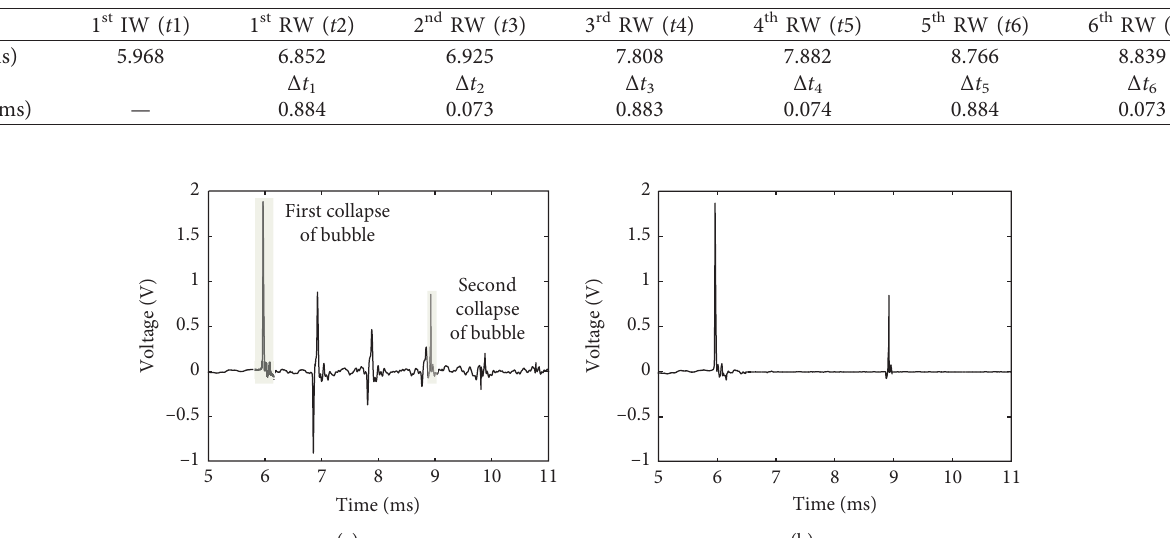
Table 1: Acquisition time of initial stress wave and stress reflection wave in the first collapse of bubbles: ① 1 st IW is the time of first incident wave signal; ② 1 st RW is the time of the first reflected wave signal; ③ 2 nd RW is the time of the second reflected wave signal; ④ 3 rd RW, 4 th RW, and so on are the same as before.